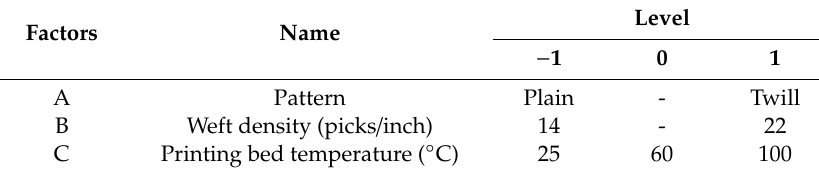
Table 4. Factors of the statistical design of experiments and their levels for thickness measurements.